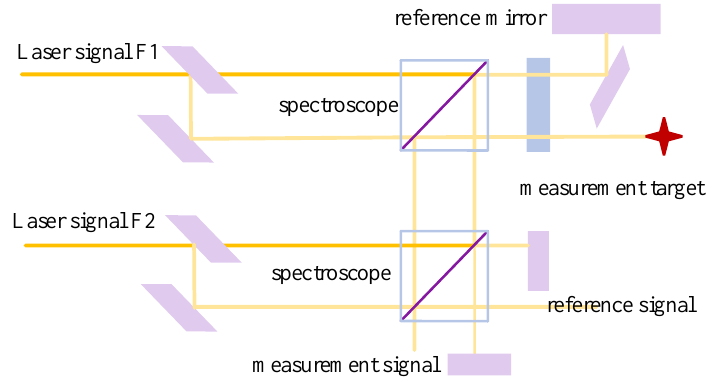
Figure 18. Schematic diagram of the LISA heterodyne interference.